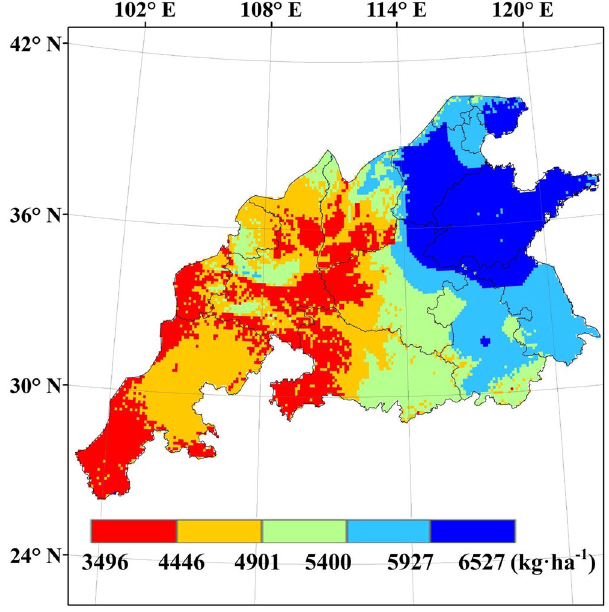
Figure 8. Spatial distribution of average actual yield of winter wheat from 1998 to 2008 in the main production regions of China (This figure was created by ArcGIS 9.3, http://www.esri.com/arcgis/).